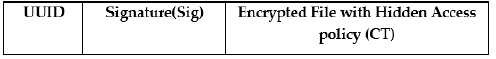
Figure 5. The outsourced data structure in the